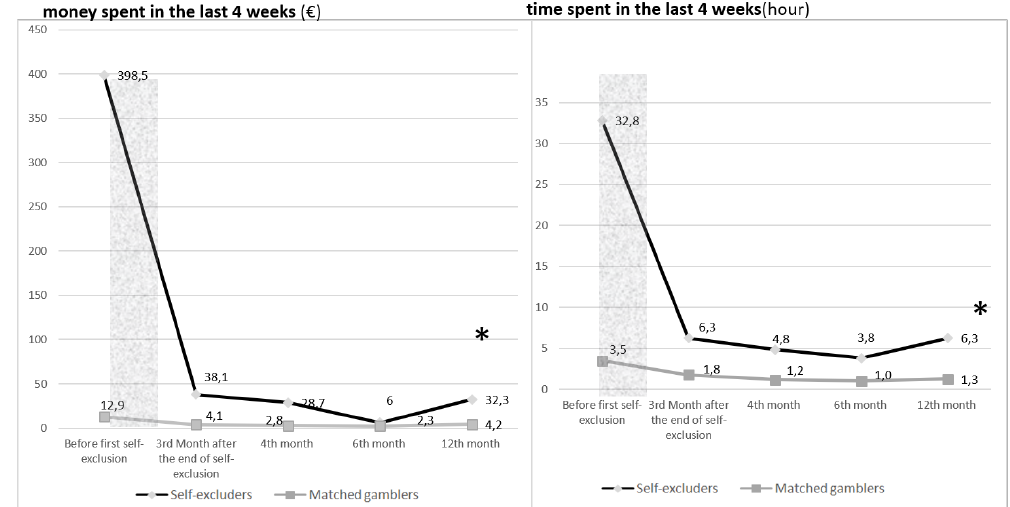
Figure 1. Evolution of money / time spent in the last 4 weeks ( € / hours) at baseline and after the end of self-exclusion period ( n = 4887 and n = 4451). (* = p -value < 0.05 — ANOVA between the mixed model with and the null model without the interaction of self-exclusion X time).